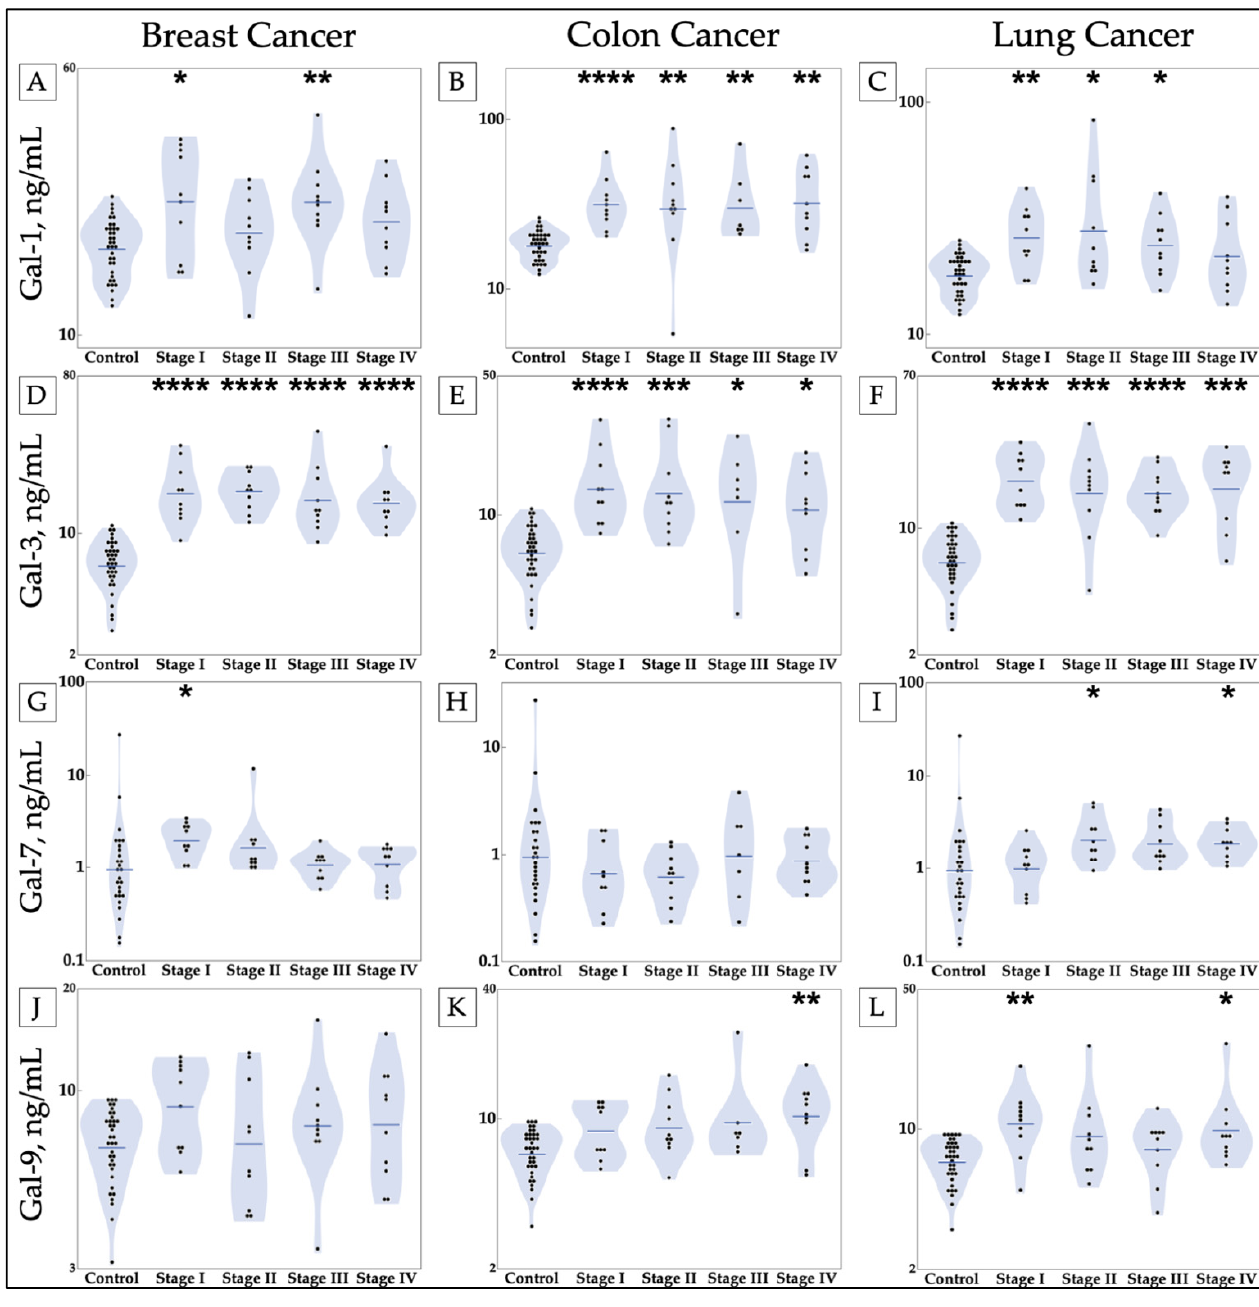
Figure 2. Elevations in circulating levels of galectins-1, -3, -7, and -9 occur in breast, colon, and lung cancer patients compared with healthy controls. Cancer galectin levels were determined by ELISA of patient samples. ( A ) A statistically significant difference in galectin-1 is shown between stages I and III of breast cancer and healthy controls; ( B ) galectin-1 is shown to be increased in all stages of colon cancer compared with healthy controls; ( C ) a statistically significant difference in galectin-1 is shown in stages I, II, and III of lung cancer. ( D – F ) Galectin-3 is observed to be elevated in all stages of all cancers, ( G – I ) a statistically significant increase in serum galectin-7 is observed in stage I of breast cancer and stages II and IV of lung cancer, and ( J – L ) galectin-9 is shown to be increased in stage IV of colon cancer and stages I and IV of lung cancer as compared with healthy controls. Stars indicate the p -values of nonparametric comparisons with control using the Steel method (* p ≤ 0.05, ** p ≤ 0.01, *** p ≤ 0.001, **** p ≤ 0.0001). Gal = galectin.